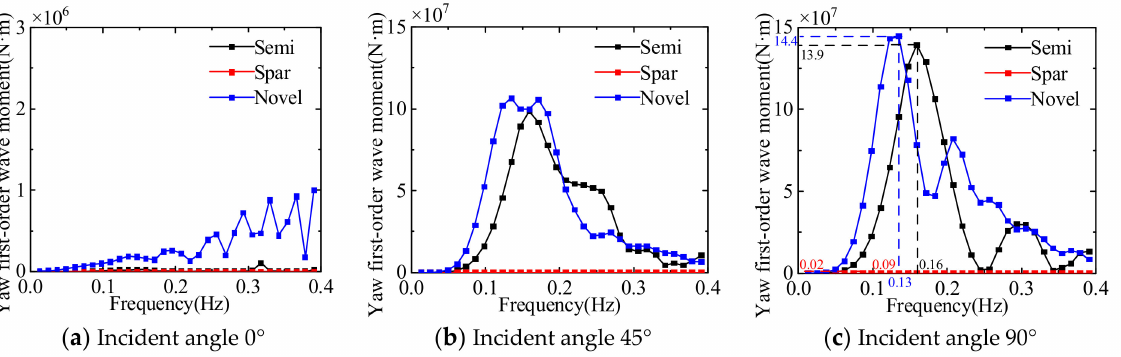
Figure 16. Comparison of the first-order wave moment in the yaw direction of three floating